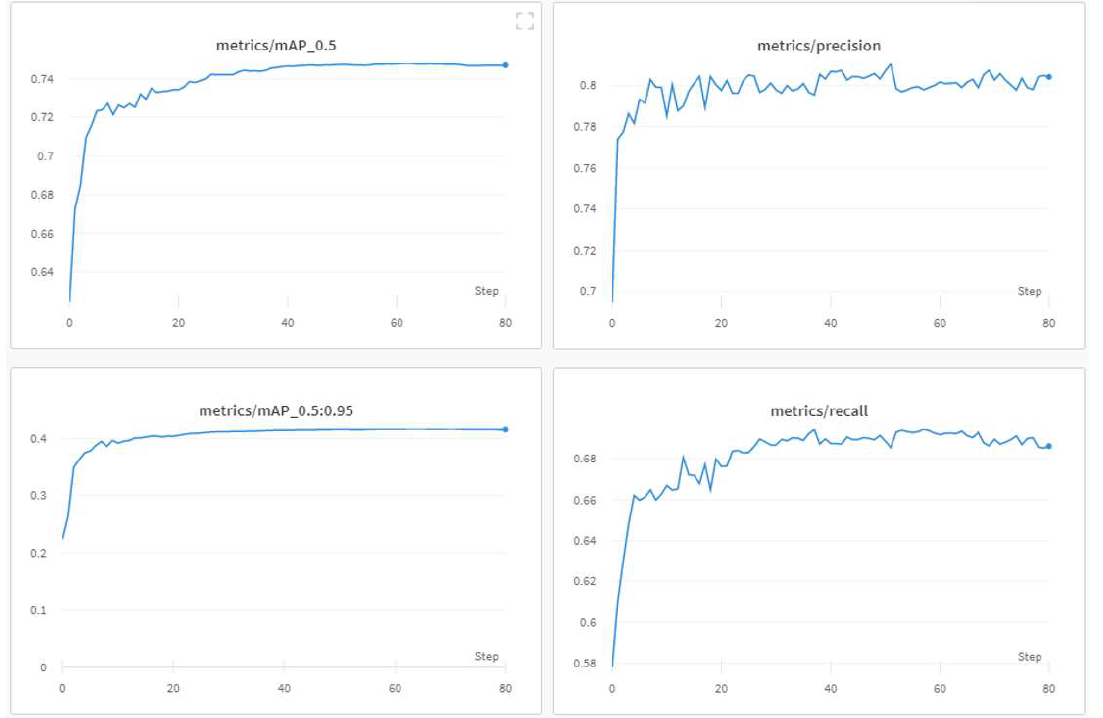
Figure 9. Basic training metrics of the custom model.